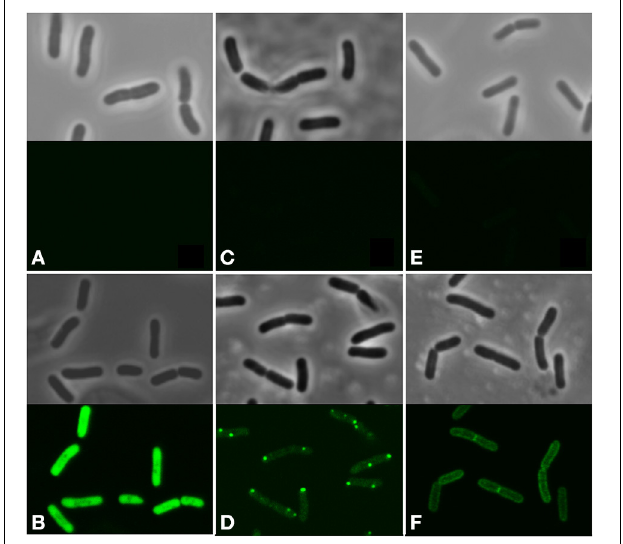
FIGURE 1 | Representative phase contrast (upper panel) and fluorescent microscopy (lower panel) images of recombinant L. salivarius cells. (A) Control cells pNZ:8048. (B) L. salivarius GFP cells displayed fluorescence observed throughout individual bacilli. (C) Negligible levels of fusion fluorescence were observed from MMP-GFP cells, (D) while fluorescent foci, suggestive of aggregation, were observed toward the polar regions of individual cells for the codon optimized variant MMPsynth-GFP. (E) Low levels of fluorescence prevented determination of the subcellular localization of native MptD-GFP fusions within L. salivarius cells, while (F) codon optimized MptDsynth-GFP fusion proteins demonstrated the tendency to localize toward the cellular membrane periphery. All culture assays were performed in triplicate, multiple images were taken from each sample and representative pictures were chosen. Bars represent 5 μ